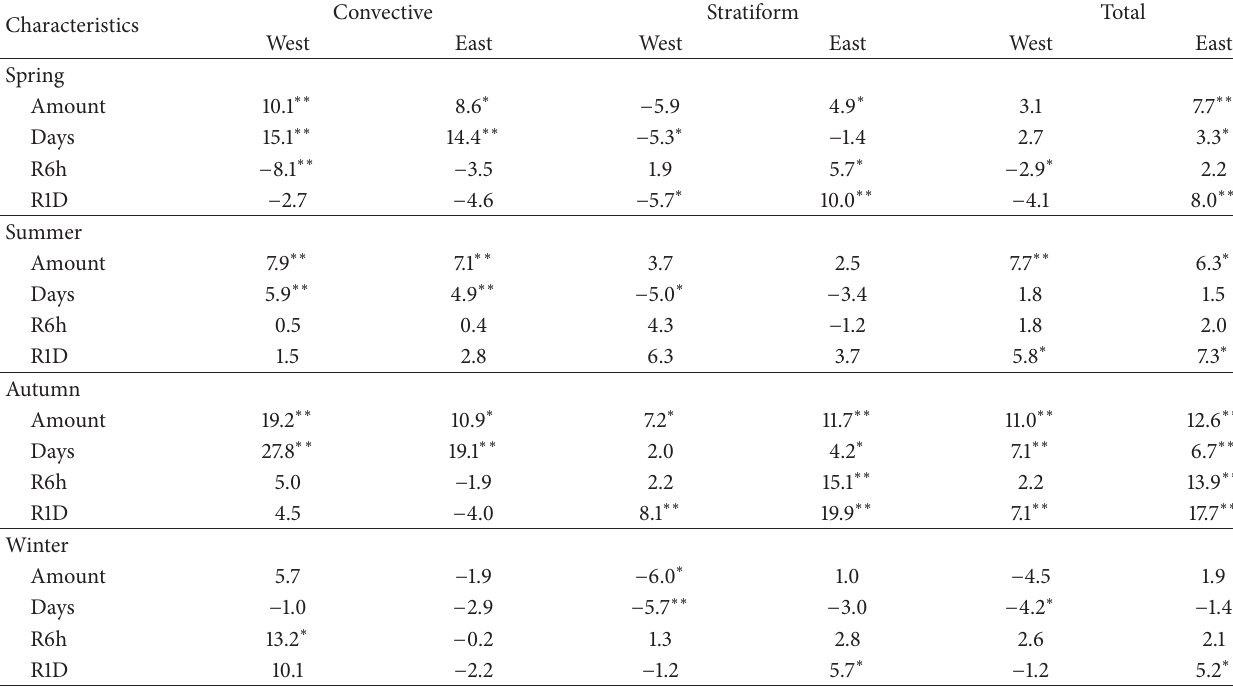
Table 3: Trend magnitudes (expressed as relative change of the examined characteristics in %/10 years, from linear regression) of average precipitation characteristics over 1982–2010 for the western and the eastern part of the Czech Republic. ∗ ( ∗∗ ) denotes trend significant at the 0.2 (0.1)